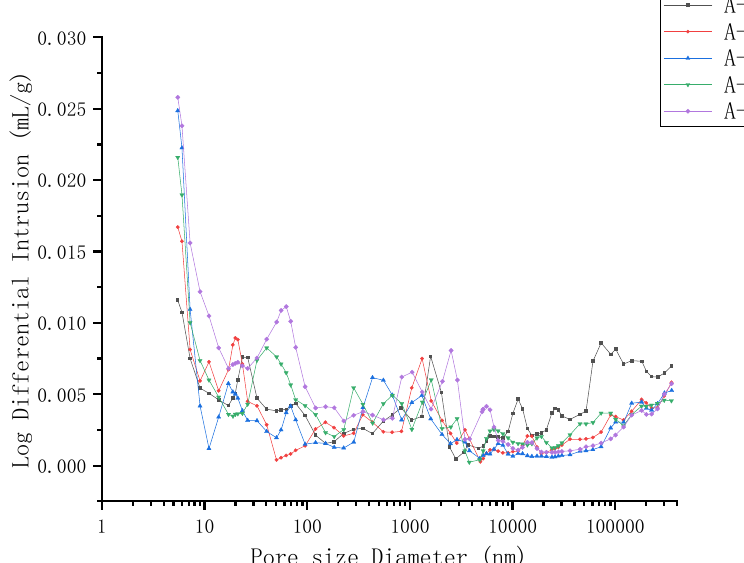
Figure 12. Twenty-eight-day pore size distribution of RPC samples with different numbers.